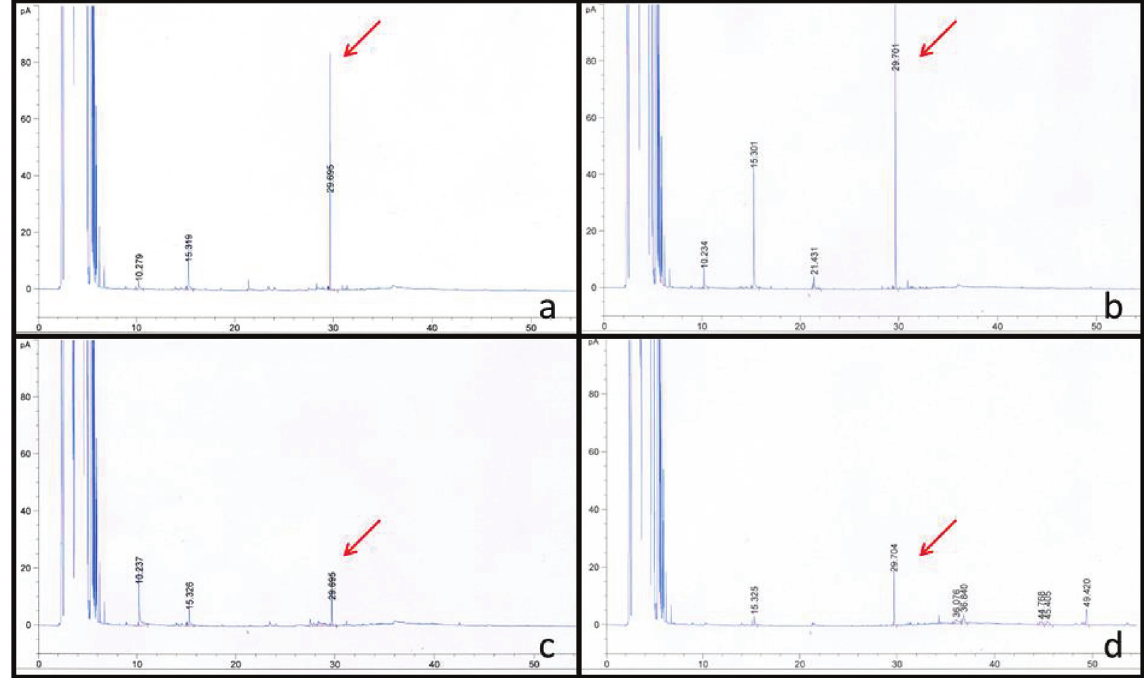
Figure 4 - Chromatographic profiles of volatile solutions obtained from soybean plants, Embrapa 48 (a, c) and PI 230970 (b, d) genotypes. The arrow in- dicatesthevolatilecompoundthathaditsemissionreducedafterinoculationwiththefungus.(a,b)False-inoculatedsoybeanplants.(c,d)Soybeanplants that were Phakoposra pachyrhizi